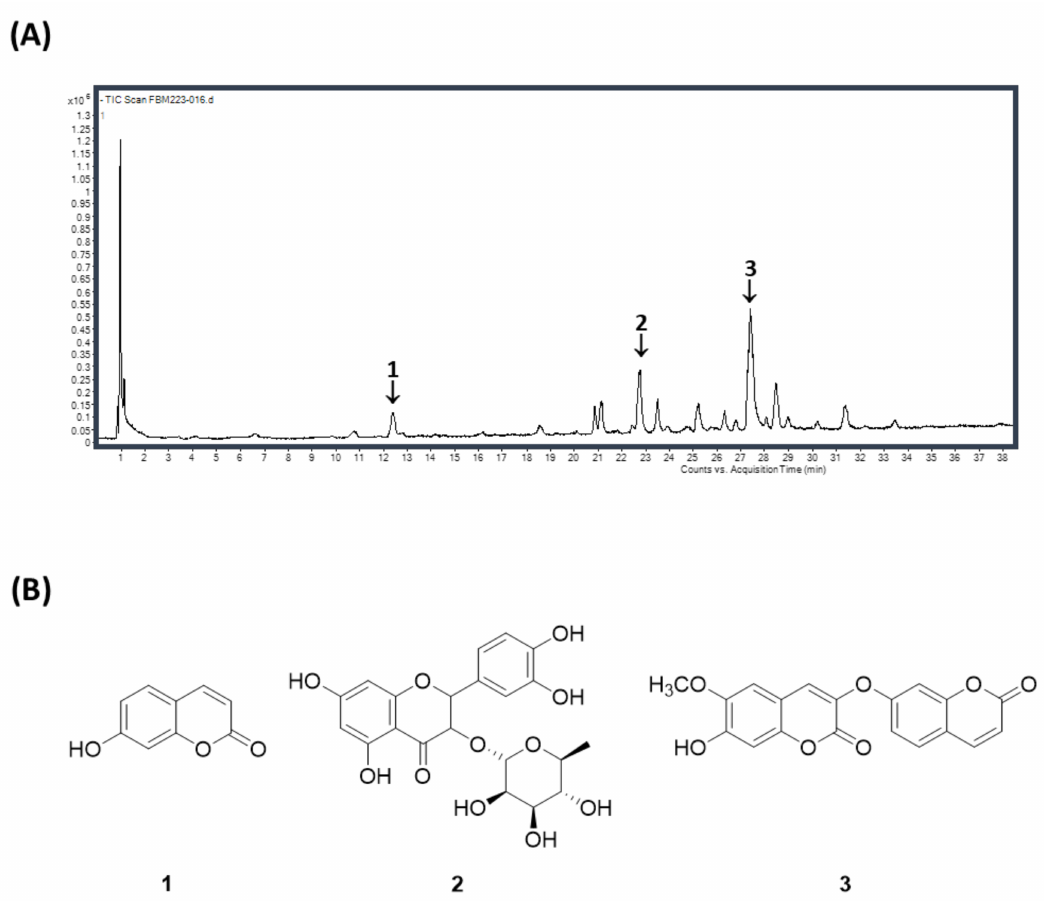
Figure 6. HPLC chromatogram of the phenolic compounds of Wikstroemia indica ( A ) and the chemical structures of its major compounds ( B ). Phytochemical characterization of the W. indica EtOH extract was performed using HPLC / MS. 1 : umbelliferone ( t R 12.368 min), 2 : quercitrin ( t R 22.718 min), and 3 : daphnoretin ( t R 27.377